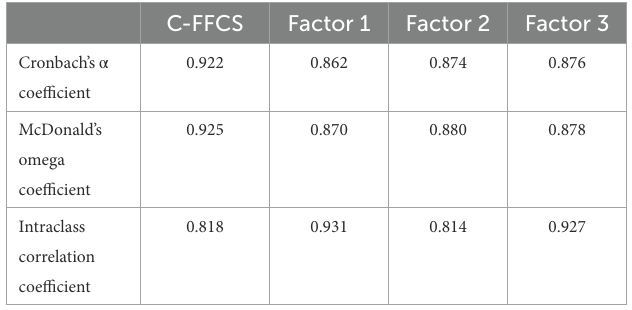
TABLE 6 Reliability analysis of the C-FFCS ( N =